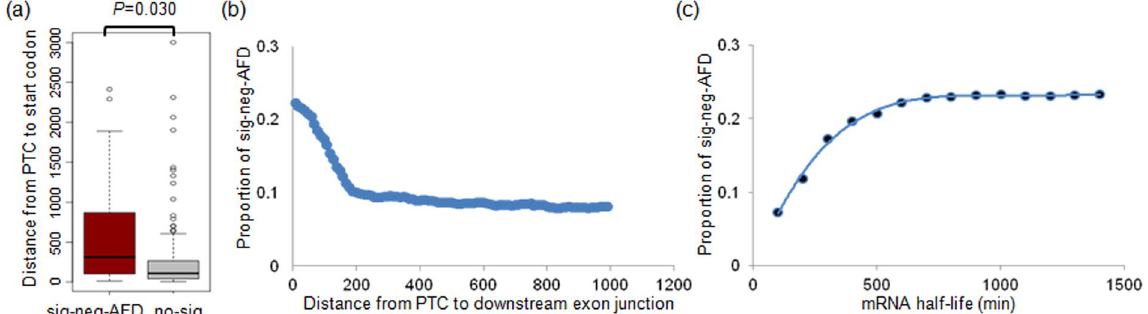
Figure 3. The relationship between the location of PTC and NMD. ( a ) The distance of PTC from start codons are shown for sig-neg-AFD mutations (red) and the other mutations (gray). ( b ) Scatterplot shows the distance of PTC to downstream exon junction. The x -axis is represented as a cumulative sum. The point is marked on every 10 nts. ( c ) The sig-neg-AFDs ratio are plotted against the mRNA half-life. The minutes on the x-axis are represented as a cumulative